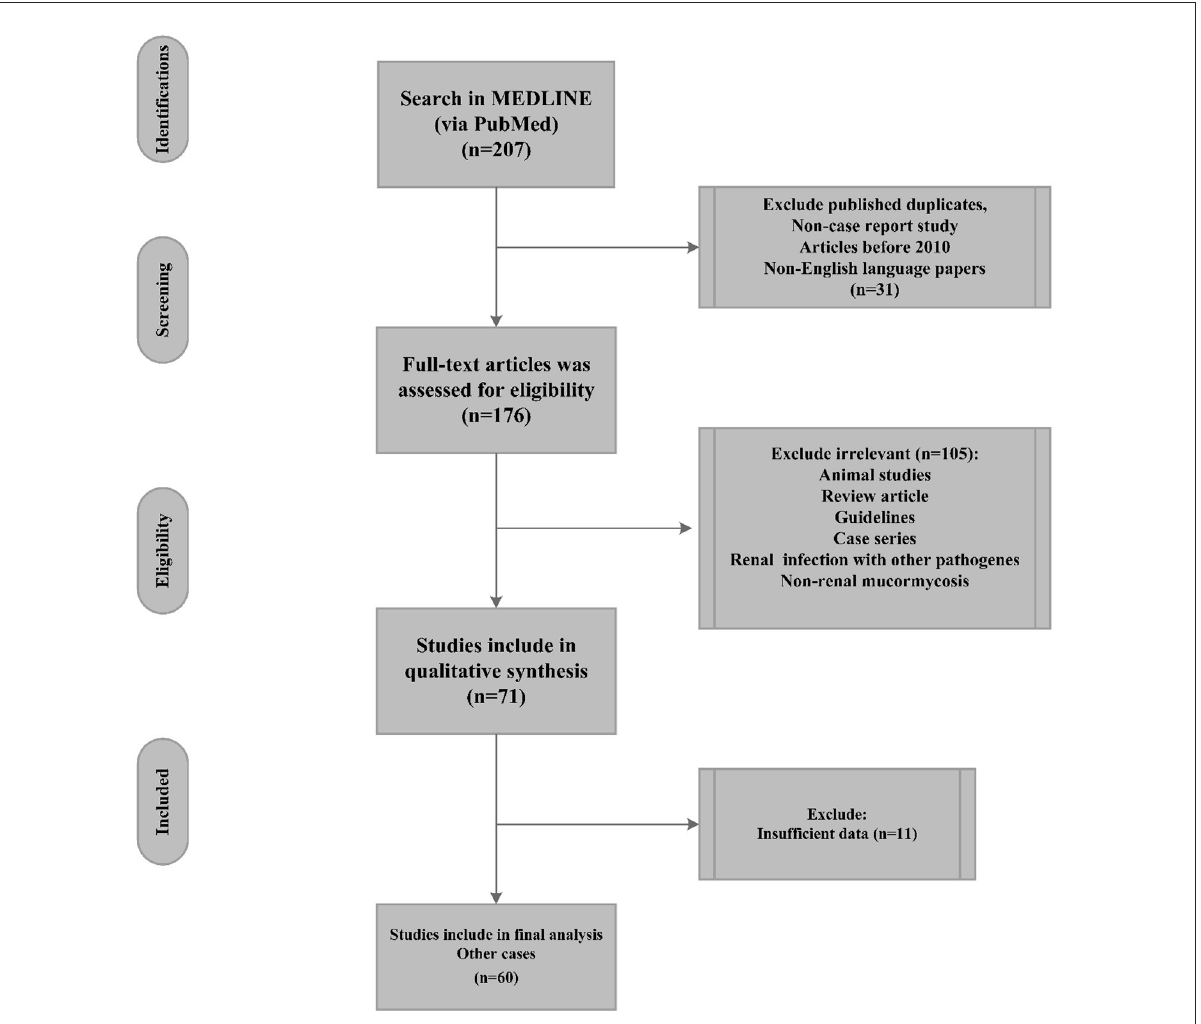
FIGURE1 Flow chart of renal mucormycosis publication selection (PubMed reported cases 2010 until April 2022) and their inclusion in the systematic